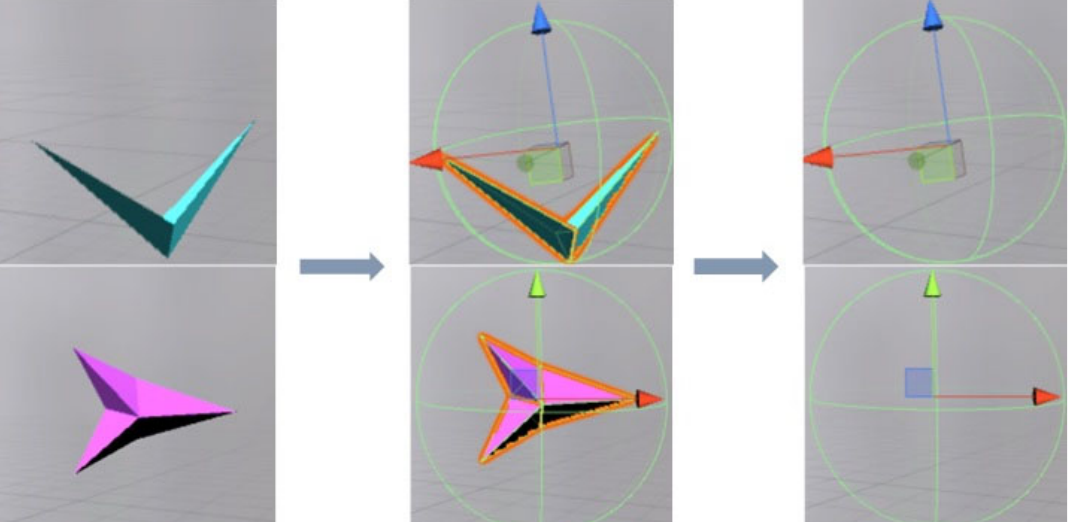
Fig. 5. Enclosing of the small items into the largest enclosing ball